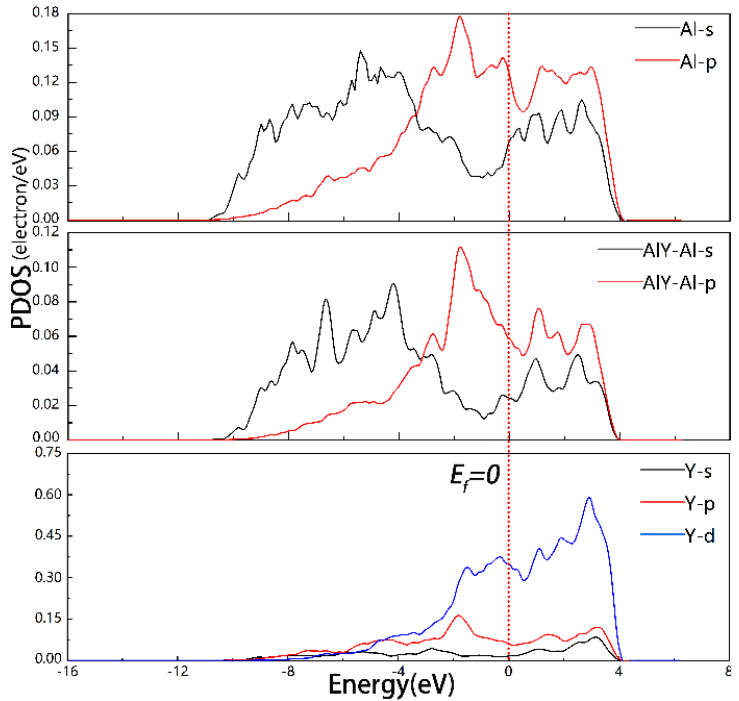
Figure 7. PDOS of Model2 of Al 3 Y(110)|Al(110) interface. In Figure 8, the PDOS for the Al, AlY-Al, and Y for the Al 3 Y(111)|Al(111) interface were equal to − 1.82, − 0.37, and 1.51, and 2.15 eV, respectively, which indicates the formation of s-p-d hybrid